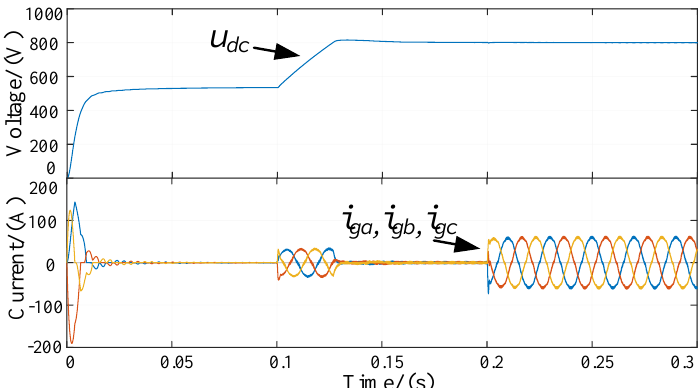
Figure 16. Simulation results of DC side voltage and reactive power compensation in the shunt